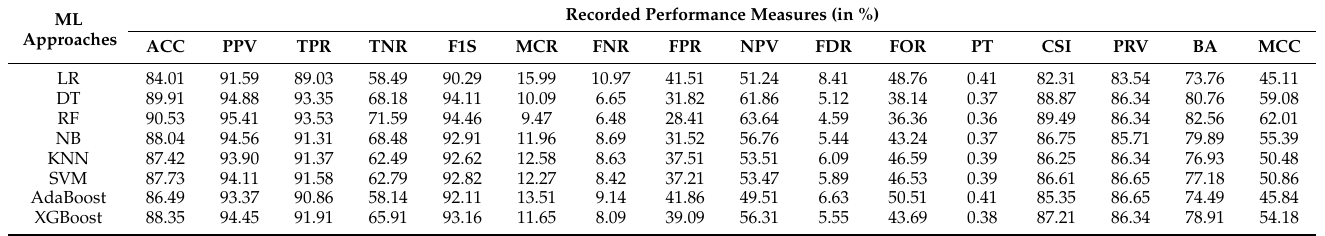
Table 6. Recorded results of various performance parameters based on various ML approaches.